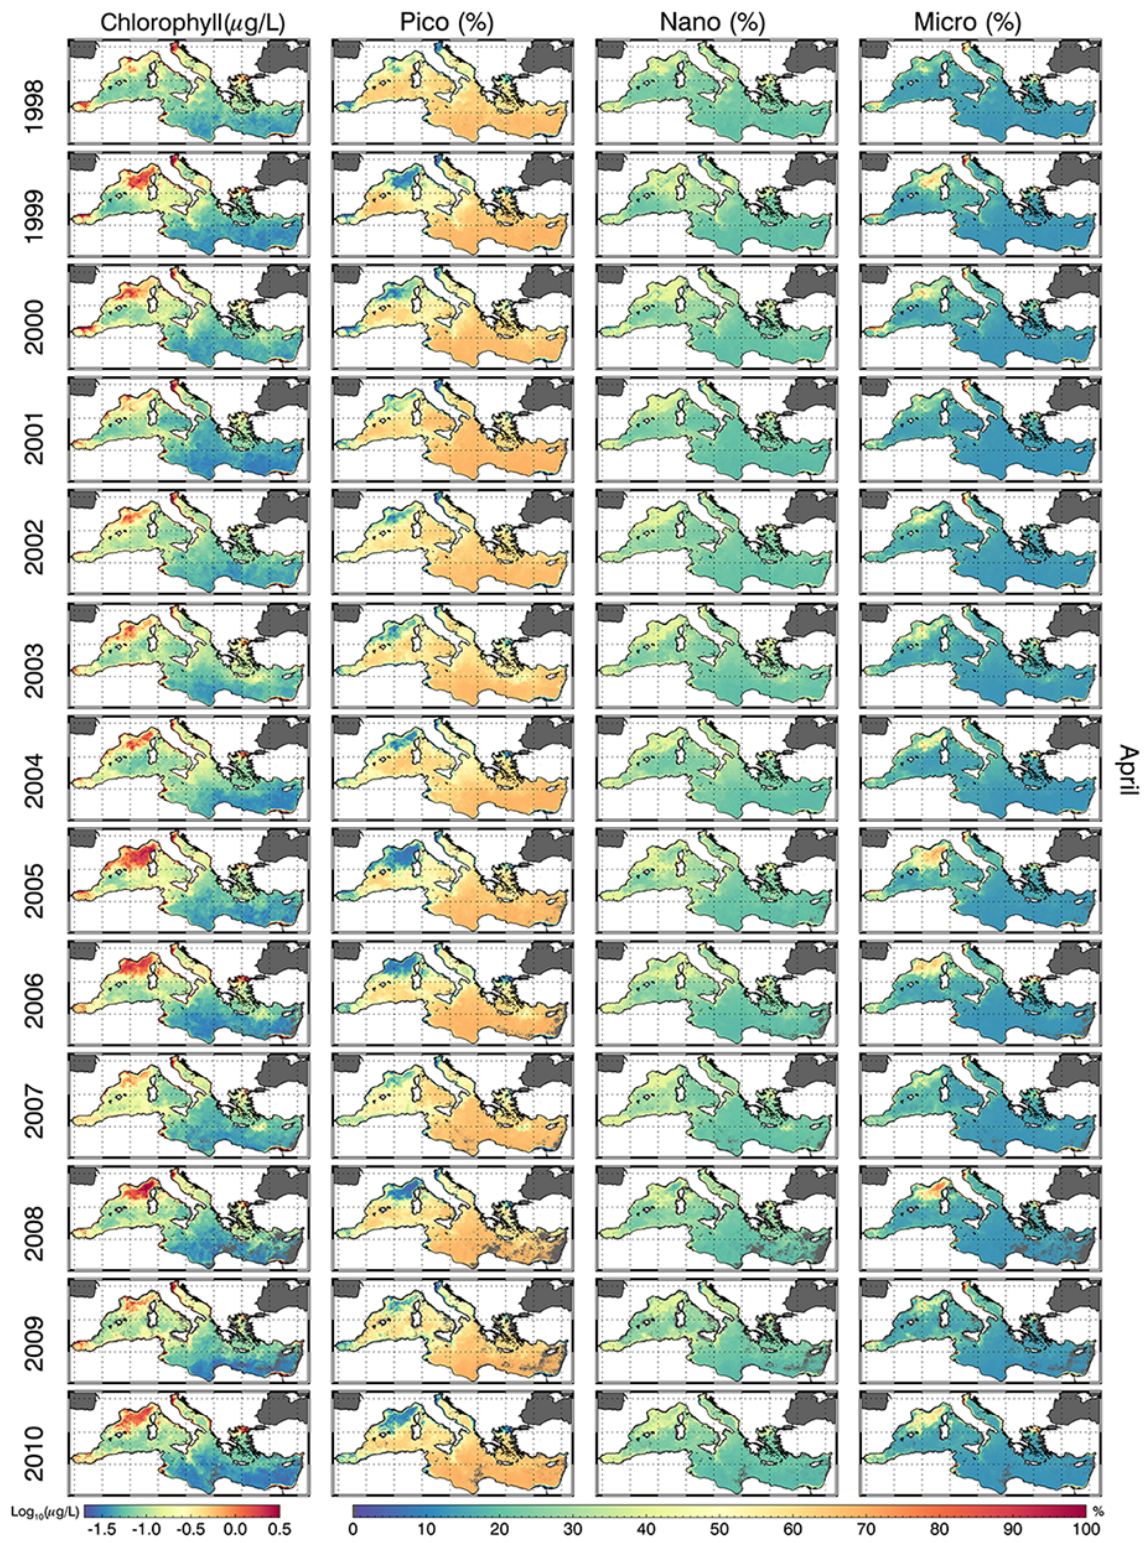
Figure 6. Monthly maps of inter-annual variability (1998–2010) of TChl a and PSCs over the entire basin for April. The first panel refers to TChl a (µgL − 1 ) , the second to the pico-phytoplankton fraction on TChl a (%), the third and the fourth, respectively, refer to the nano- and micro-phytoplankton fractions